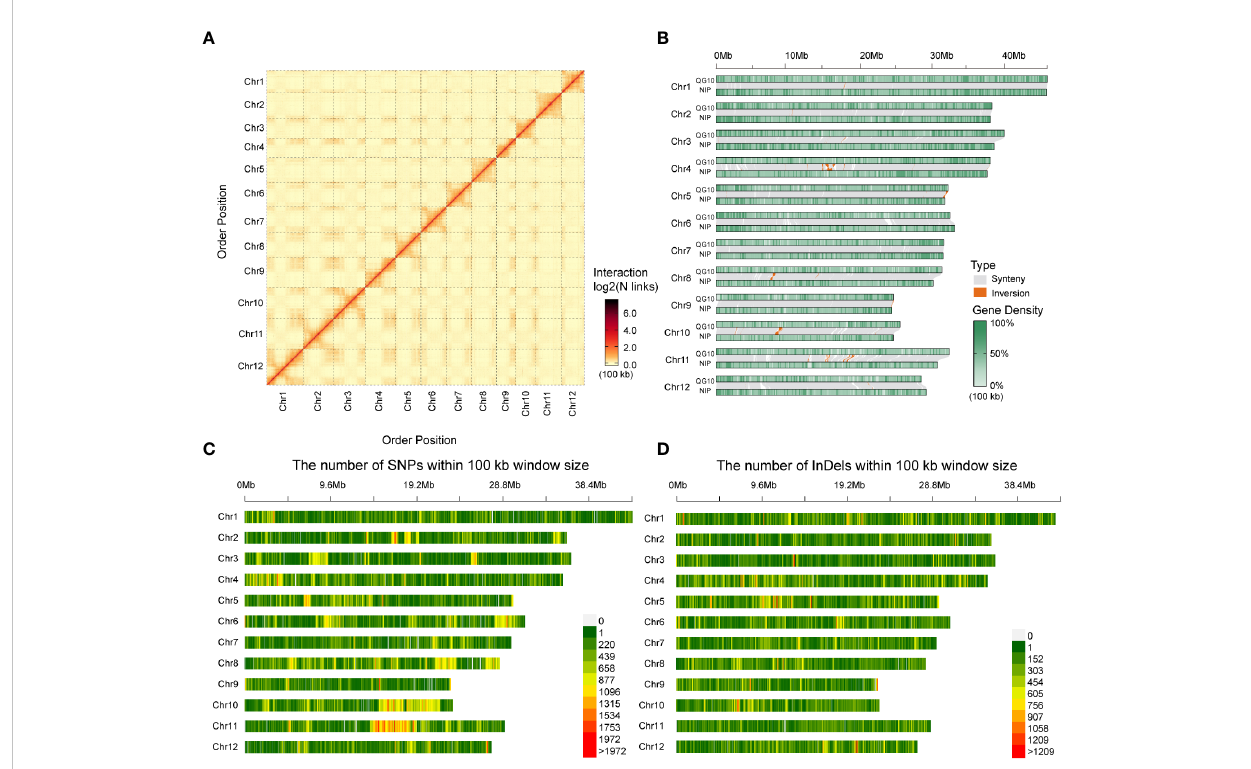
FIGURE 2 Characteristics of Qigeng10 (QG10) genome and synteny examining, SNPs and InDels mining, Synteny/Inversion comparison with Nipponbare. (A) , Visualization of the Hi-C signals in the whole genome of QG10. (B) , Chromosomal synteny among QG10 and Nipponbare reference genomes of rice. (C) , Distribution of SNPs between QG10 and Nipponbare. (D) , Distribution of InDels between QG10 and Nipponbare.